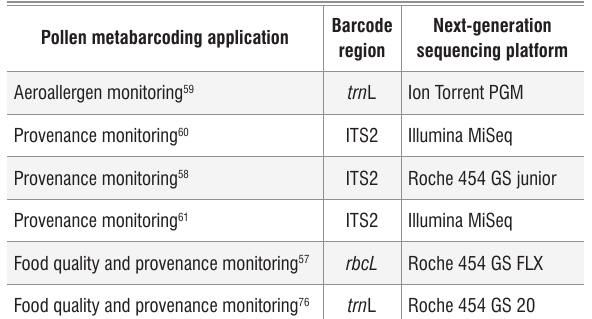
A comparison of the recently published pollen metabarcoding studies, focusing on the application of the study, the barcode region selected and the next-generation sequencing platform used in the